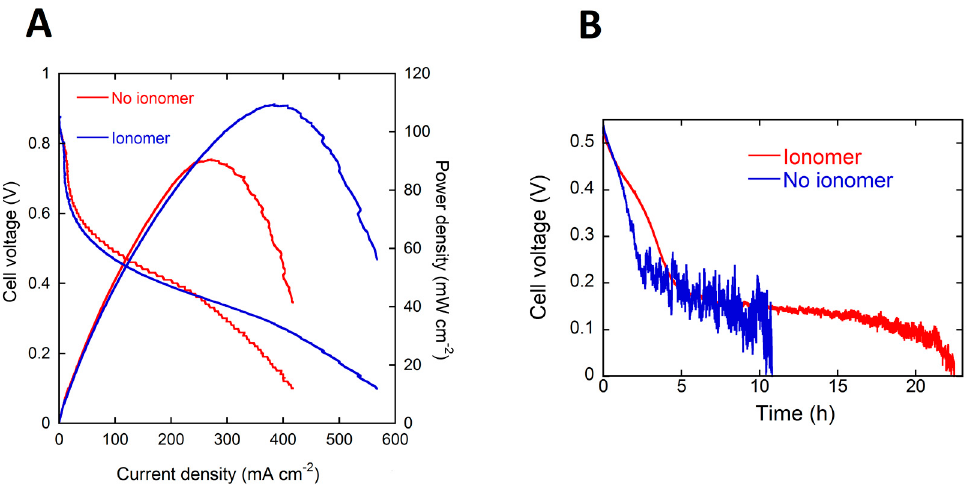
Figure 5. ( A ) Potential and power density (vs. current density) curves for the DFFC containing the Pd/C-CeO 2 anode, FeCo/C cathode, A201 AEM and fueled with 4 M HCOOK ( B ) energy delivery from 4 M HCOOK fuel with and without ionomer in the catalyst layer.